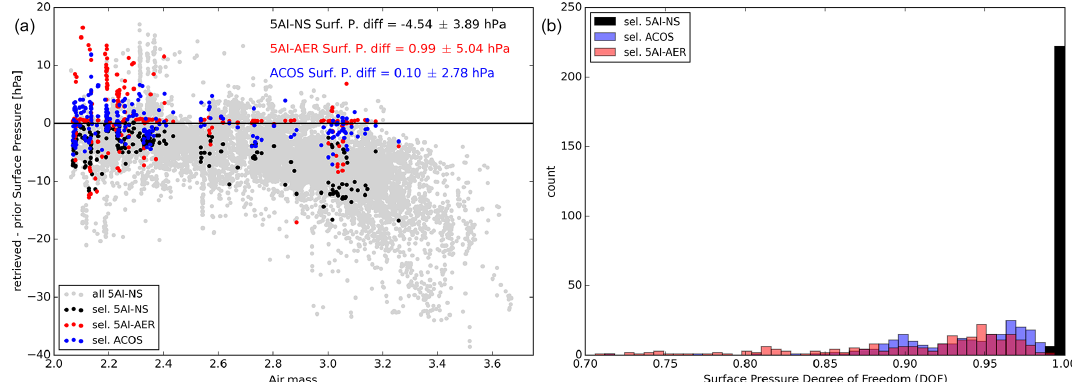
Figure 8. Retrieved surface pressure air mass dependence (a) for all 5AI-NS target OCO-2 soundings (light grey), 5AI-NS soundings selected in the small subsample that passed all filters (black), and the corresponding 5AI-AER (red) and ACOS (blue). Distributions of surface pressure degrees of freedom are shown (b) for 5AI-NS (black), 5AI-AER (red) and ACOS (blue).